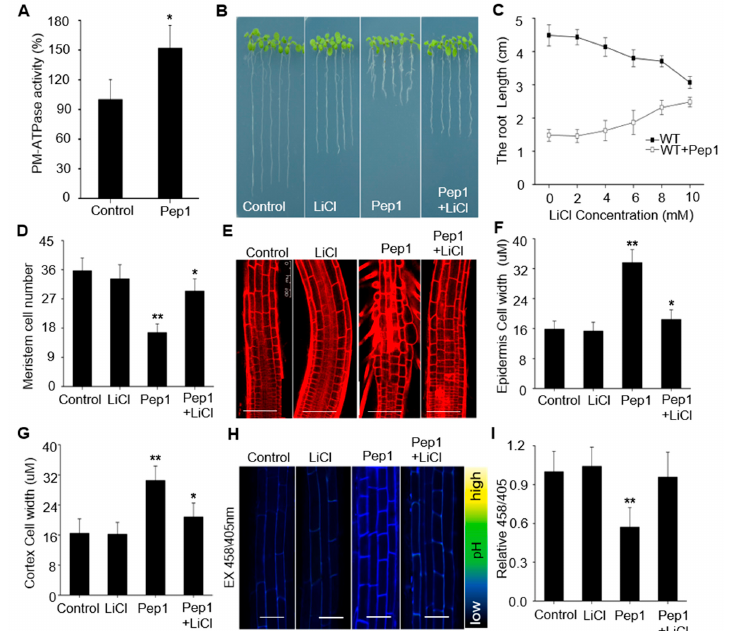
Figure 3. Pep1 activates the plasma membrane-localized H + -ATPases (PM H + -ATPases) to inhibit root growth. ( A ) The PM H + -ATPase activity in microsomal membranes isolated from 5-week-old wild-type (WT) roots treated with 100 nM Pep1 for 72 h, the PM H + -ATPase activity in control condition was normalized to 1.0. Data are mean ± SD of three independent experiments. The growth phenotype ( B ) and the length of primary root ( C ) of three-day-seedings were transferred on half-strength MS agar medium supplemented with or without (Control) 10 mM LiCl, 100 nM Pep1, or 10 mM LiCl + 100 nM Pep1 for 6 days. ( D ) Statistics of the number of meristematic cells in root cortex as in ( B ). Data in ( B ), ( C , D ) are means ± SD from three independent experiments ( n = 24, n represents the number of samples). ( E ) The root longitudinal structures in WT seedlings. Five-day-old seedings were transferred on half-strength MS agar medium supplemented with or without (Control) 10 mM LiCl, 100 nM Pep1, or 10 mM LiCl + 100 nM Pep1 for 24 h. the roots were stained with 5 uM PI for 15 s and photographed under a confocal laser-scanning microscope. Bars = 100 um. ( F , G ) Quantitative analysis of epidermal and cortex cell width in TZ as indicated in ( E ). Data are means ± SD ( n = 32 cells from 8 roots per treatment). ( H ) HPTS fluorescence signals in 6-day-old WT roots treated with or without (Control) 10 mM LiCl, 100 nM Pep1, or 10 mM LiCl + 100 nM Pep1 for 8 h. The root-apex fluorescent signals represented protonated HPTS (EX405) (Excitation 405 nm, emission peak 514 nm), deprotonated HPTS form (EX458) (Excitation 458 nm, emission peak 514 nm), and the merge of EX458 / EX405. Color code (black to yellow) depicts (low to high) 458 / 405 intensity. Bars = 20 um. ( I ) The summarized values on fluorescent ratio of deprotonated HPTS to protonated HPTS in the cortex cells of transition zone as indicated in ( H ). The fluorescent ratio of the control was set to 1.0, and the treatment ratio was normalized to the control ratio. Data are mean ± SD from three independent experiments ( n = 16 cells from 8 roots per treatment). Asterisks indicate statistically significant di ff erences compared with Control (Tukey‘s test; * p < 0.05, ** p <